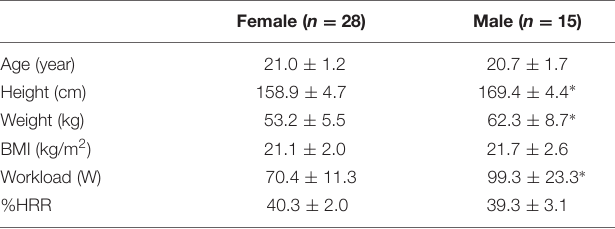
TABLE 1 | Participant characteristics and exercise